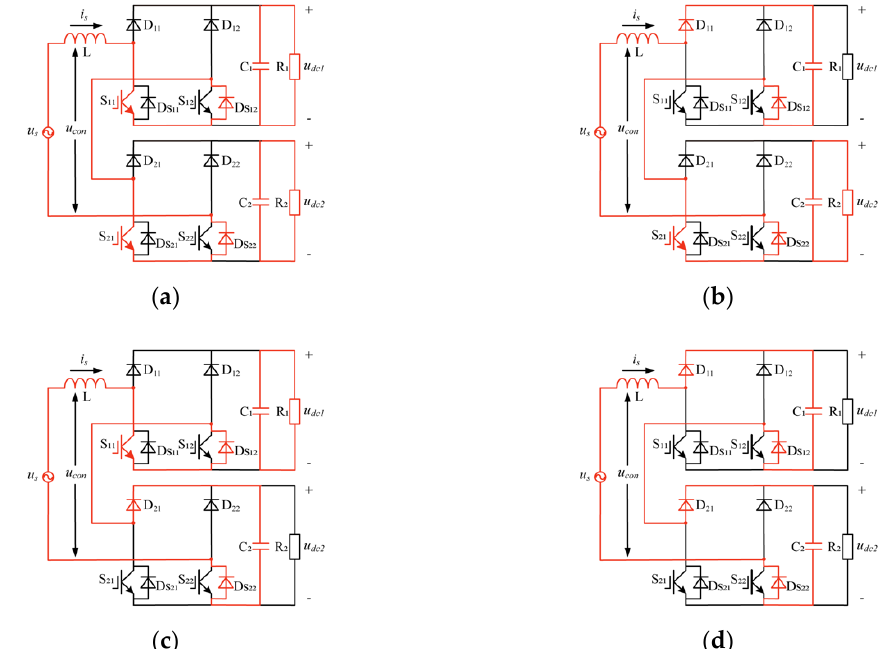
Figure 5. Current paths of the four operation modes for two-stage cascaded bridgeless rectifier; ( a ) Mode I; ( b ) Mode II; ( c ) Mode III; ( d ) Mode IV.